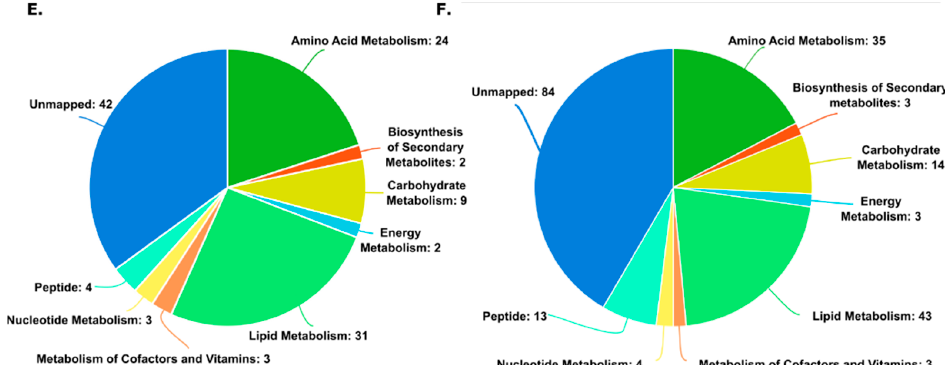
Figure 2. Summary of metabolites identified in parental and CBPR cell lines. ( A ) Metabolites puta- tively identified in OVCAR-5 cell line pair. OVCAR-5 parental total= 369, OVCAR-5 CBPR total= 370, unique to OVCAR-5 parental= 10, unique to OVCAR-5 CBPR= 1, in both OVCAR-5 parental and CBPR= 359. ( B ) Volcano plot showing metabolites with 1.5-fold (=0.58 log2) differential abun- dance in OVCAR-5 parental compared to CBPR. Twenty-nine metabolites (5 identified with refer- ence standards indicated by bold outline) were upregulated, and 7 metabolites (6 identified with reference standards indicated by bold outline) were downregulated in parental OVCAR-5 cells. ( C ) Metabolites identified in CaOV3 cell line pair before filtering: CaOV3 parental total= 435, CaOV3 CBPR total= 428, unique to CaOV3 parental = 8, unique to CaOV3 CBPR= 1, in both CaOV3 parental and CBPR= 436. ( D ) Volcano plot showing metabolites with 1.5-fold (=0.58 log2) differential abun- dance in CaOV3 parental compared to CBPR. Twenty-nine metabolites were seen to be upregulated (4 identified with reference standards indicated by bold outline) and 11 metabolites (2 identified with reference standards indicated by bold outline) were downregulated in parental CaOV3 cells. ( E ) Pie chart of metabolite classes identified in OVCAR-5 parental and CBPR cell lines. ( F ) Pie chart of metabolite classes identified in CaOV3 parental and CBPR cell lines.